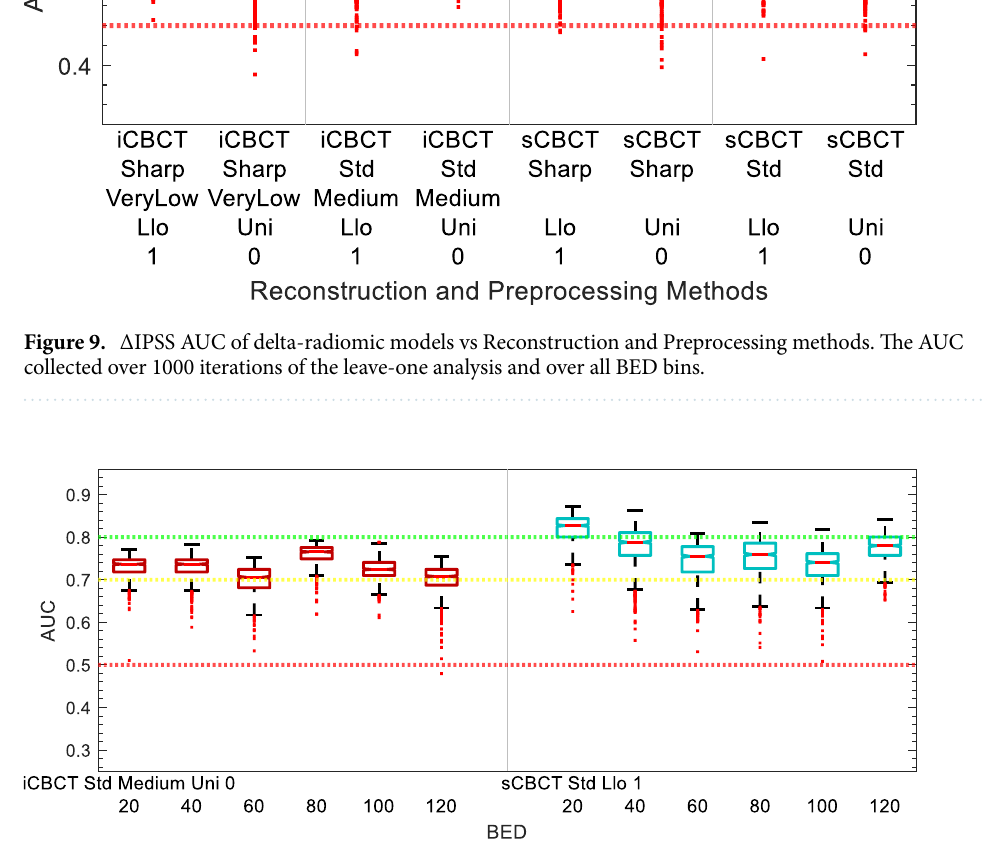
Figure 10. ∆IPSS AUC of delta-radiomic models vs BED bins. The AUC collected over 1000 bootstrapping iterations using the leave-one